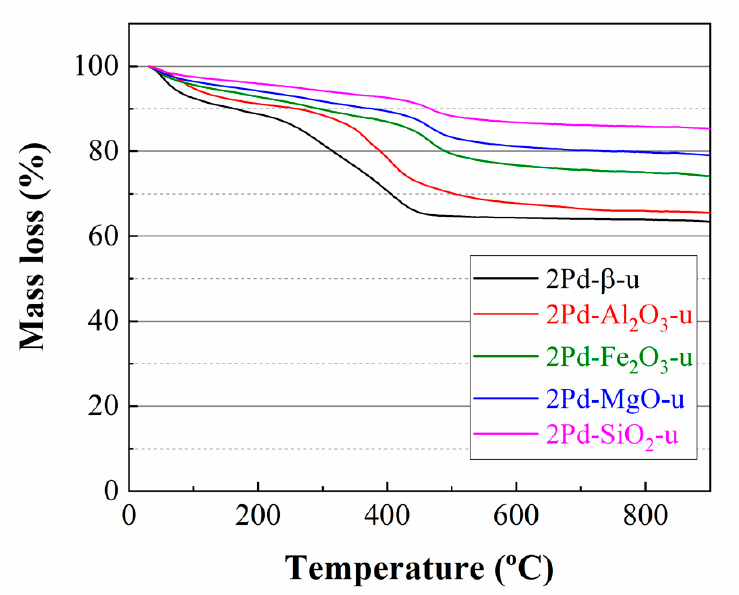
Figure 14. Thermogravimetric analysis of Pd-based catalysts, after FUR oxidative condensation Experimental conditions: temperature: 170 ◦ C, time: 3 h, catalyst loading: 0.05 g, V (ethanol) : 6 mL, reaction. Experimental conditions: temperature: 170 °C, time: 3 h, catalyst loading: 0.05 g, V (ethanol) :6 amount of base (Na 2 CO 3 ): 0.10 g, V (H 2 O 2 , 30 wt%): 0.5 mL, amount of base (Na 2 CO 3 ): 0.10 g, V (H 2 O 2 , 30 wt%): 0.5 mL.